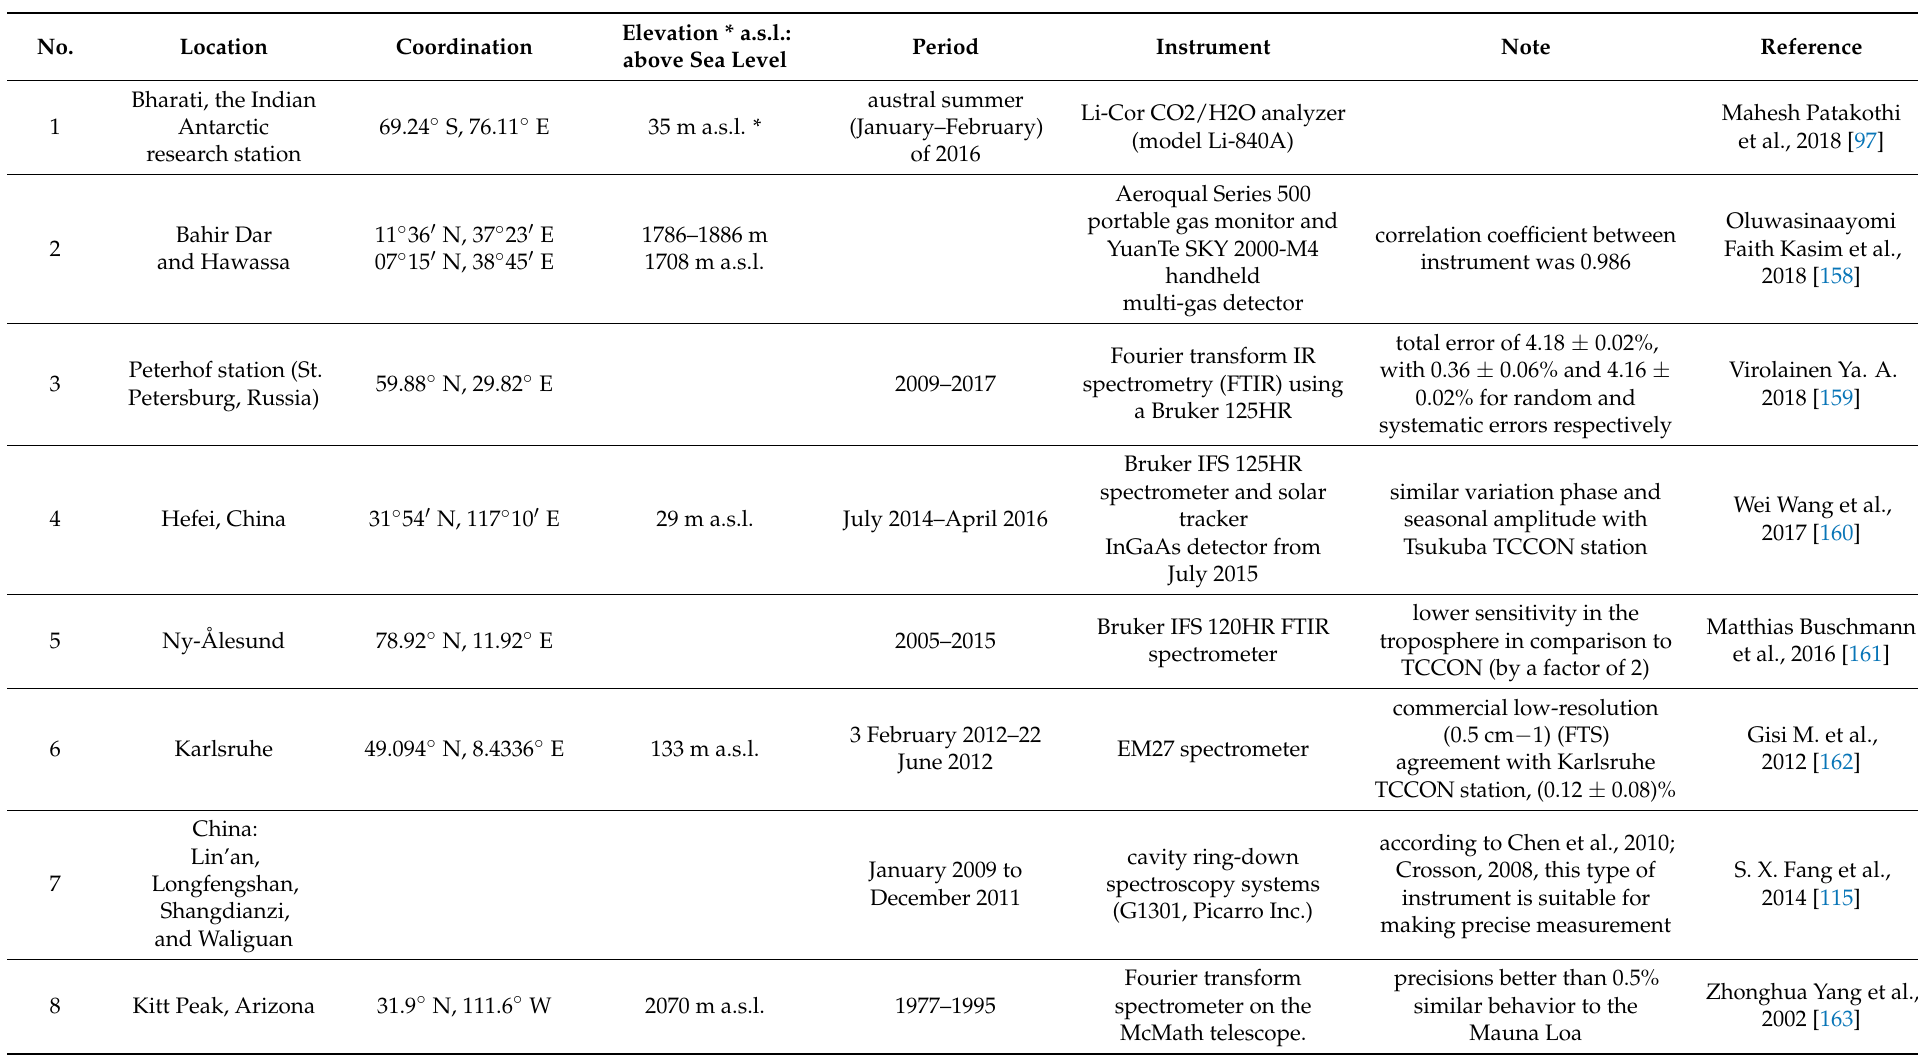
Table A5. worldwide ground-based